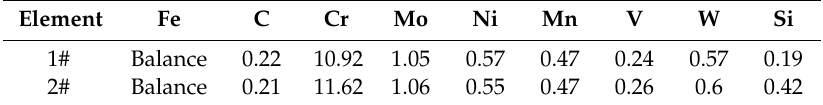
Table 1. Chemical composition of the HT-9 steel in wt.%.